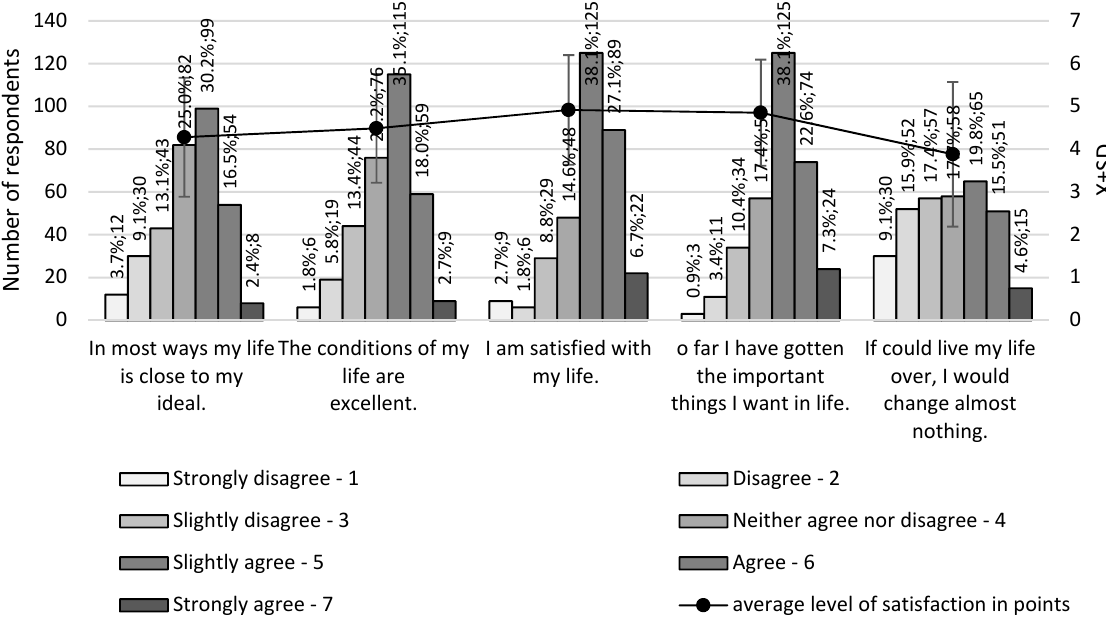
Figure 3. Results of the SWLS questionnaire in a group of study subjects. Multivariate analyses confirmed a significant effect of marital status and subjective assessment of physical condition on the average level of life satisfaction according to the SWLS scale (Table 2). Table 2. The results of multivariate analysis for the level of satisfaction according to the SWLS scale in relation to physical activity practice or frequency of physical